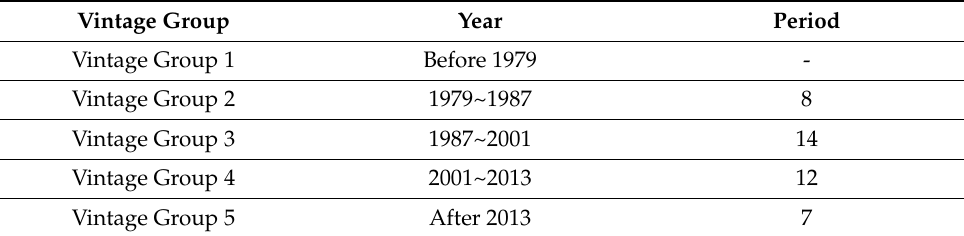
Table 6. Reference years for vintage group classification.